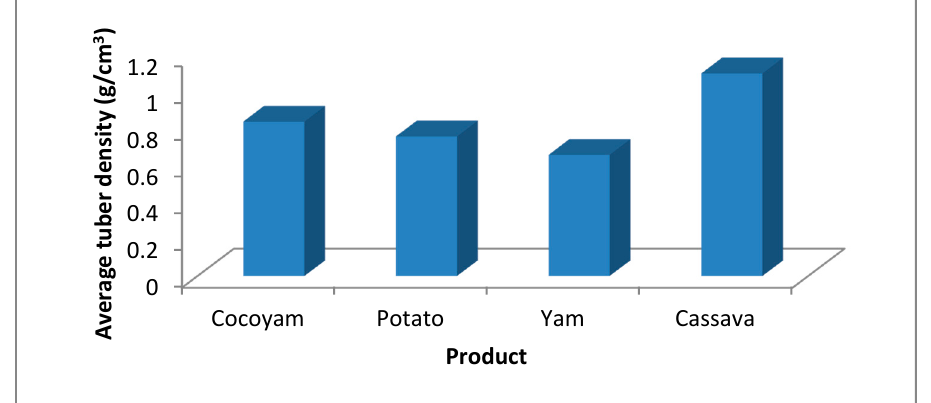
Figure 9. Comparison of tubers’ density.